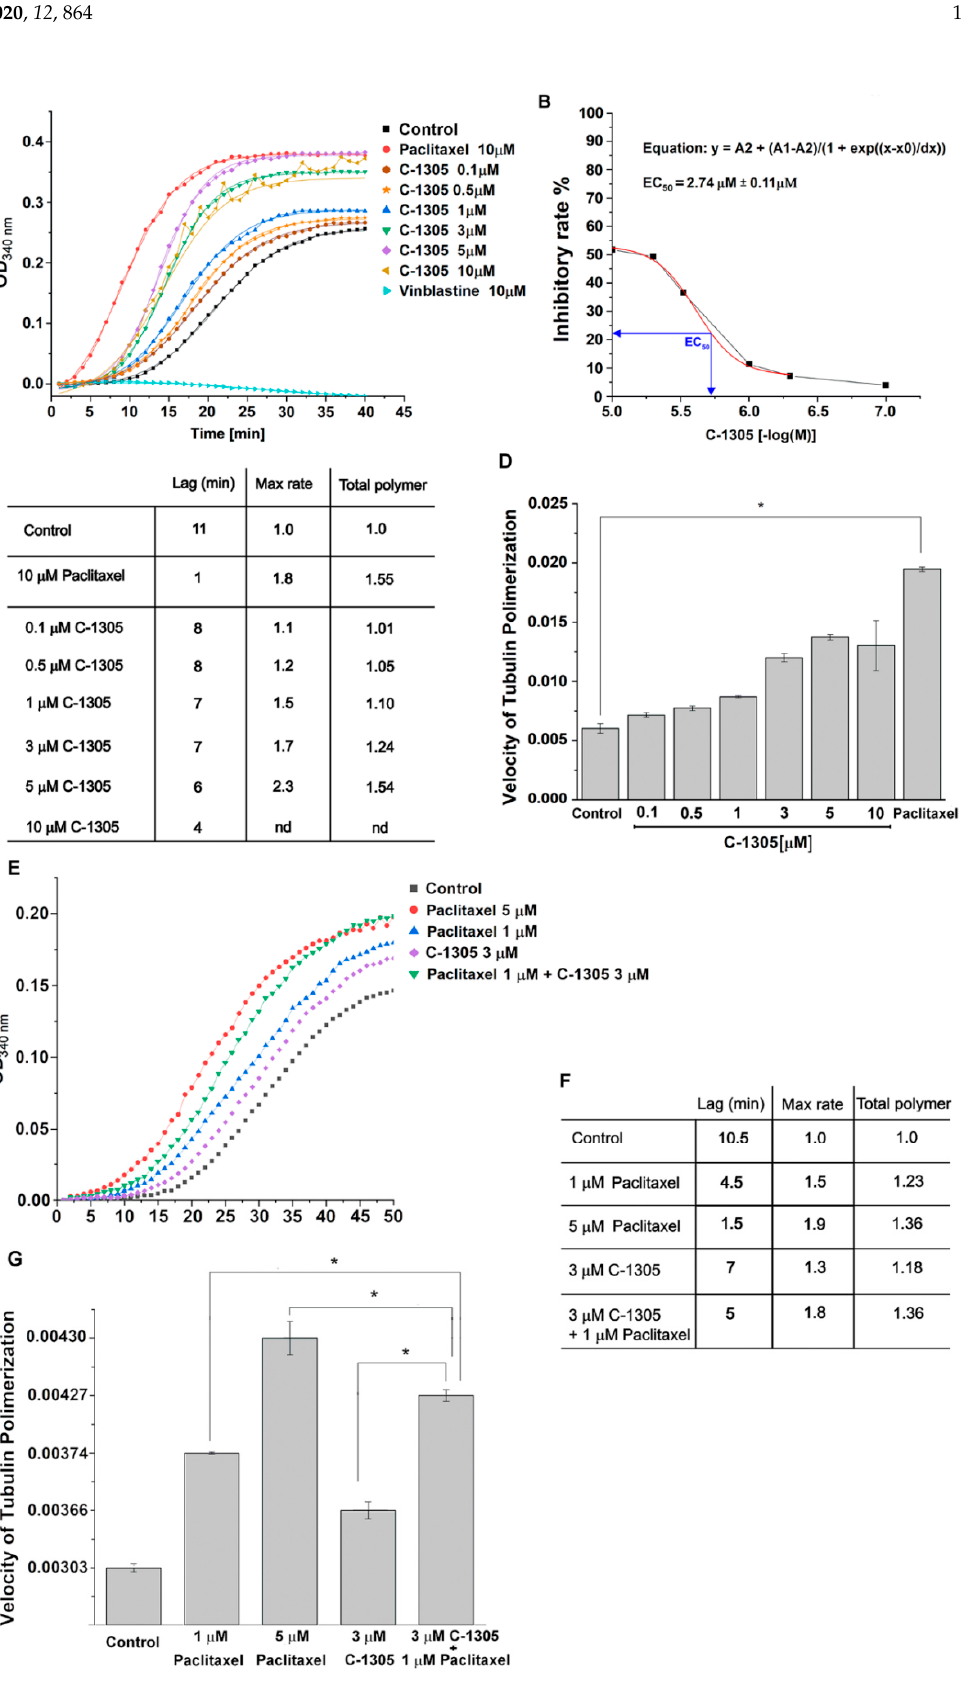
Figure 6. C-1305 acts as an efficient tubulin polymerization stabilizing agent in vitro and complements paclitaxel effects on tubulin polymerization ( A ) The kinetics of the polymerization of 3.0 mg/mL purified tubulin with microtubule stabilizers was monitored turbidimetrically at a 340 nm wavelength (OD 340 nm ). The increasing concentration of tubulin polymers as a function of time displays the characteristic sigmoidal curve for tubulin filament formation. The curve is typically divided into the lag phase (nucleation), the growth phase (polymerization), and the plateau phase [64]. The square